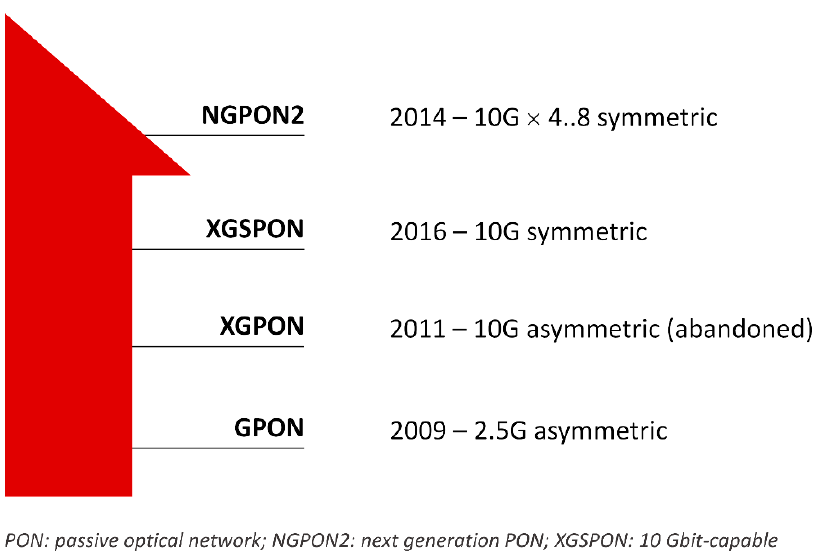
Figure 2. Recent International Telecommunication Union-Telecommunication Standardization Sector (ITU-T) based optical technologies standards evolution.